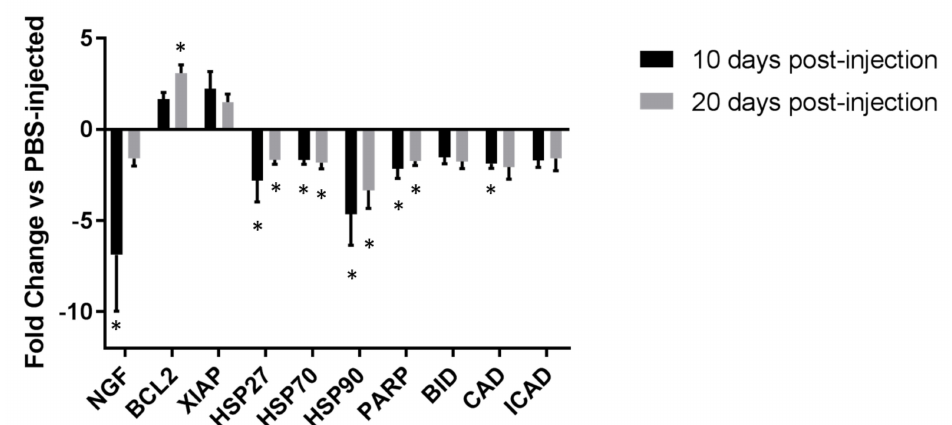
Figure 4. Quantitative real-time PCR of apoptosis mediators in synoviocytes from rhPRG4-injected Prg4 − / − mouse knees. The ∆∆ Ct calculation represented as a log2 fold change relative to Prg4 − / − littermates injected with PBS. Synovium samples were pooled from rhPRG4-injected N = 3 and PBS-injected N = 3 mice at 10 and 20 days following IA injection. Mean ± SEM displayed. * p < 0.05.